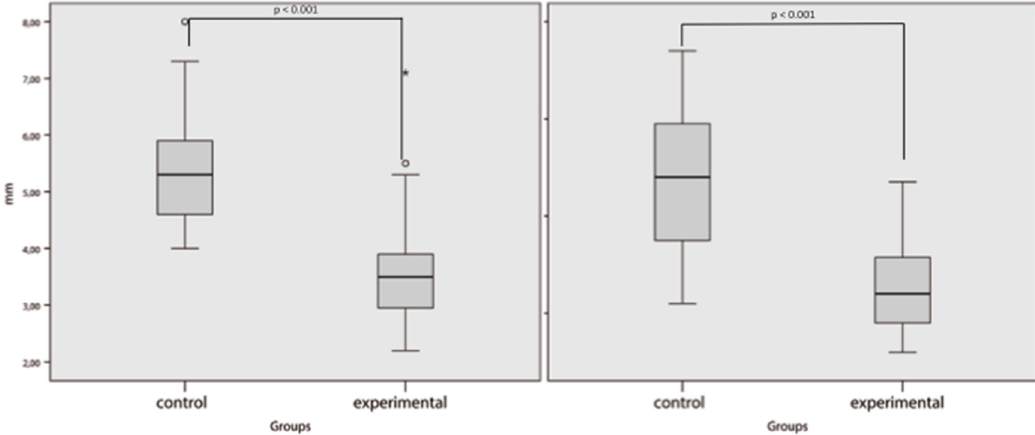
Figure 4. Sub-metatarsal fat pad. Left figure for first metatarsal and right figure for second metatarsal. p value < 0.05 was considered significant.